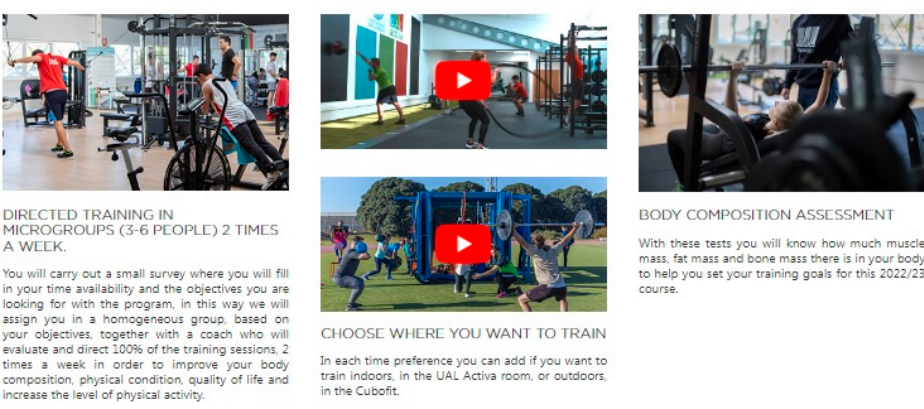
Figure 1. Information brochure of the UAL ACTIVA programme.